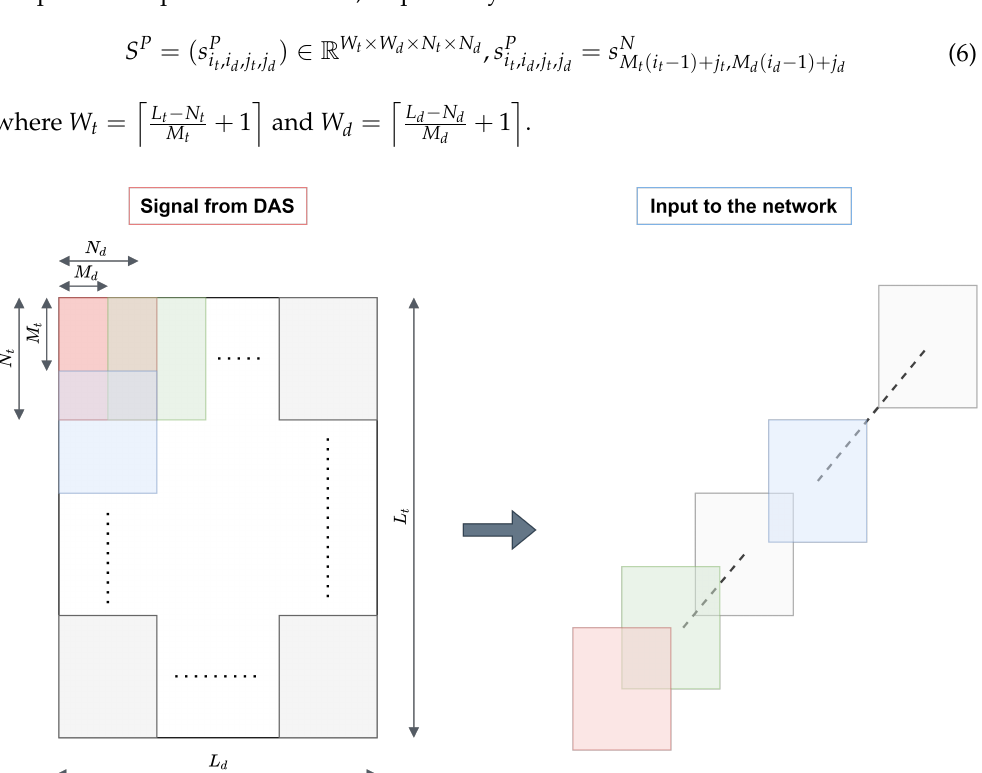
Figure 3. The signal coming from the Φ -OTDR does not serve as input directly to the network, but fixed size patches are taken